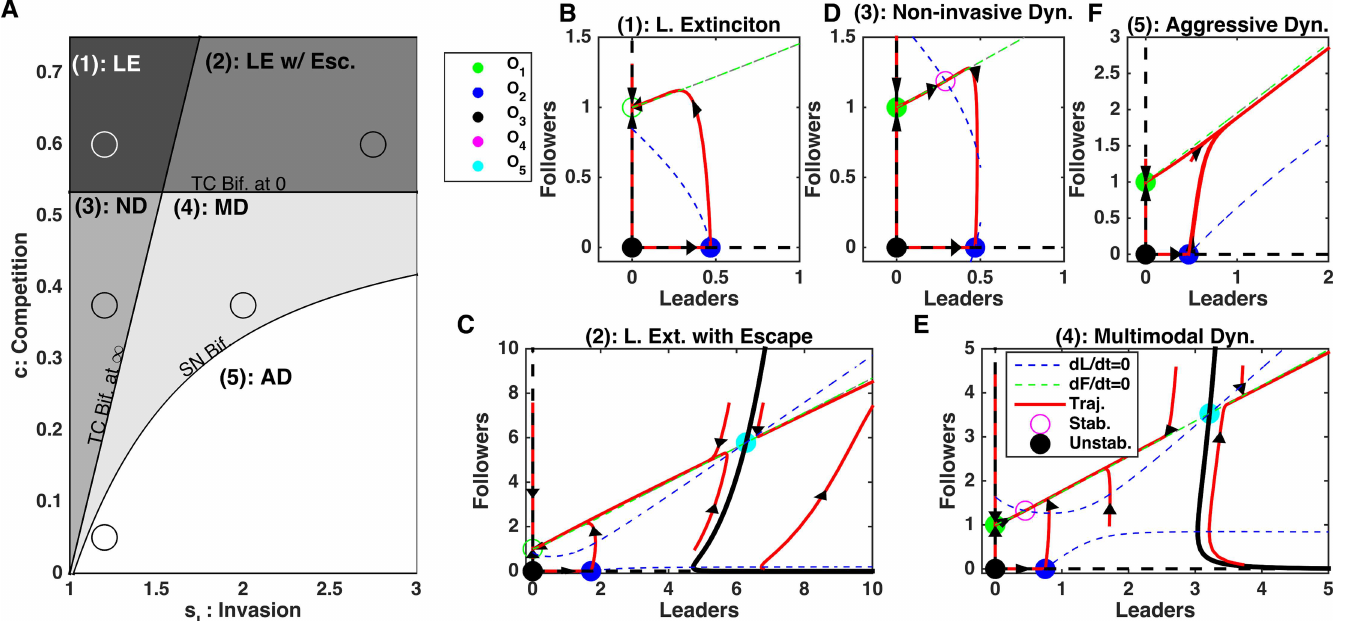
Fig 3. Dynamics of the leader and follower ecosystem. A) Bifurcation diagram sweeping leader population intrinsic feedback strengths, s Abbreviations—LE: Leader Extinction, LE w/ Esc.: Leader Extinction with Escape, ND: Non-invasive Dynamics, MD: Multimodal Dynamics, AD: Aggressive Dynamics, TC Bif. at 1 : Transcritical Bifurcation at infinity (see Methods), TC Bif. at 0: Transcritical Bifurcation at zero (see Methods), SN Bif.: Saddle Node Bifurcation (see Methods). B-E) Phase diagrams for each regime identified in A). Dashed blue and green lines are null-clines for the leaders and followers, respectively. Red curves show the trajectories of the leader-follower system from different initial conditions, with arrows denoting tangent vectors at various points. Open circles denote stable equilibrium points, stars denote unstable equilibria. Specific s L and c parameters used in panels B-E) are given by the circles in A).